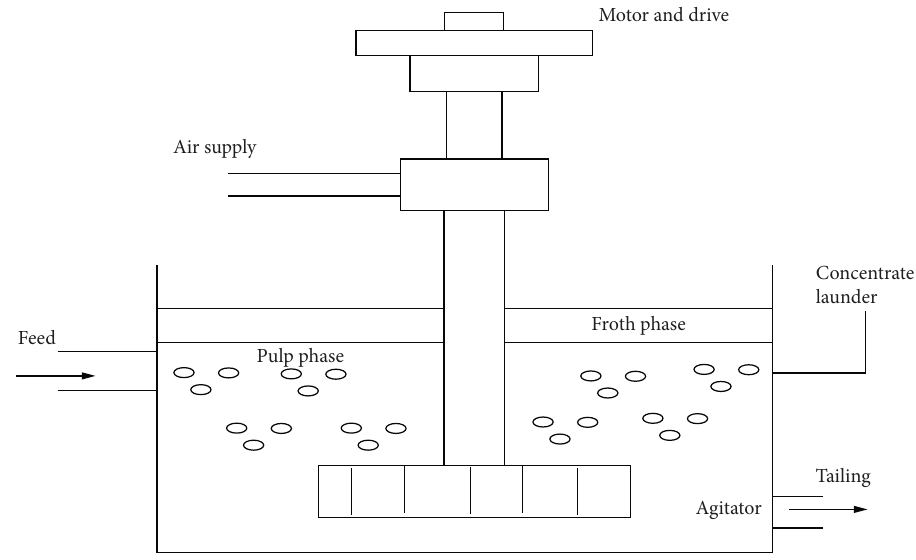
Figure 2: A representation of fotation